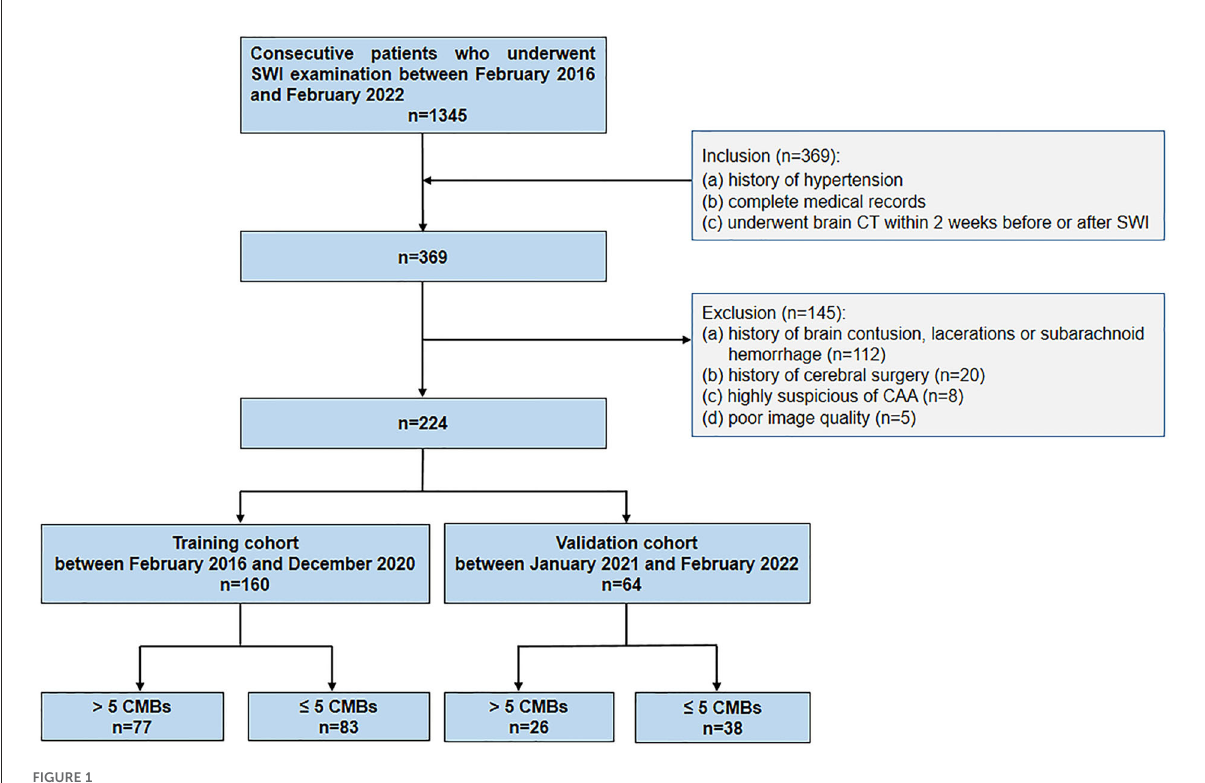
FIGURE1 Patient flow